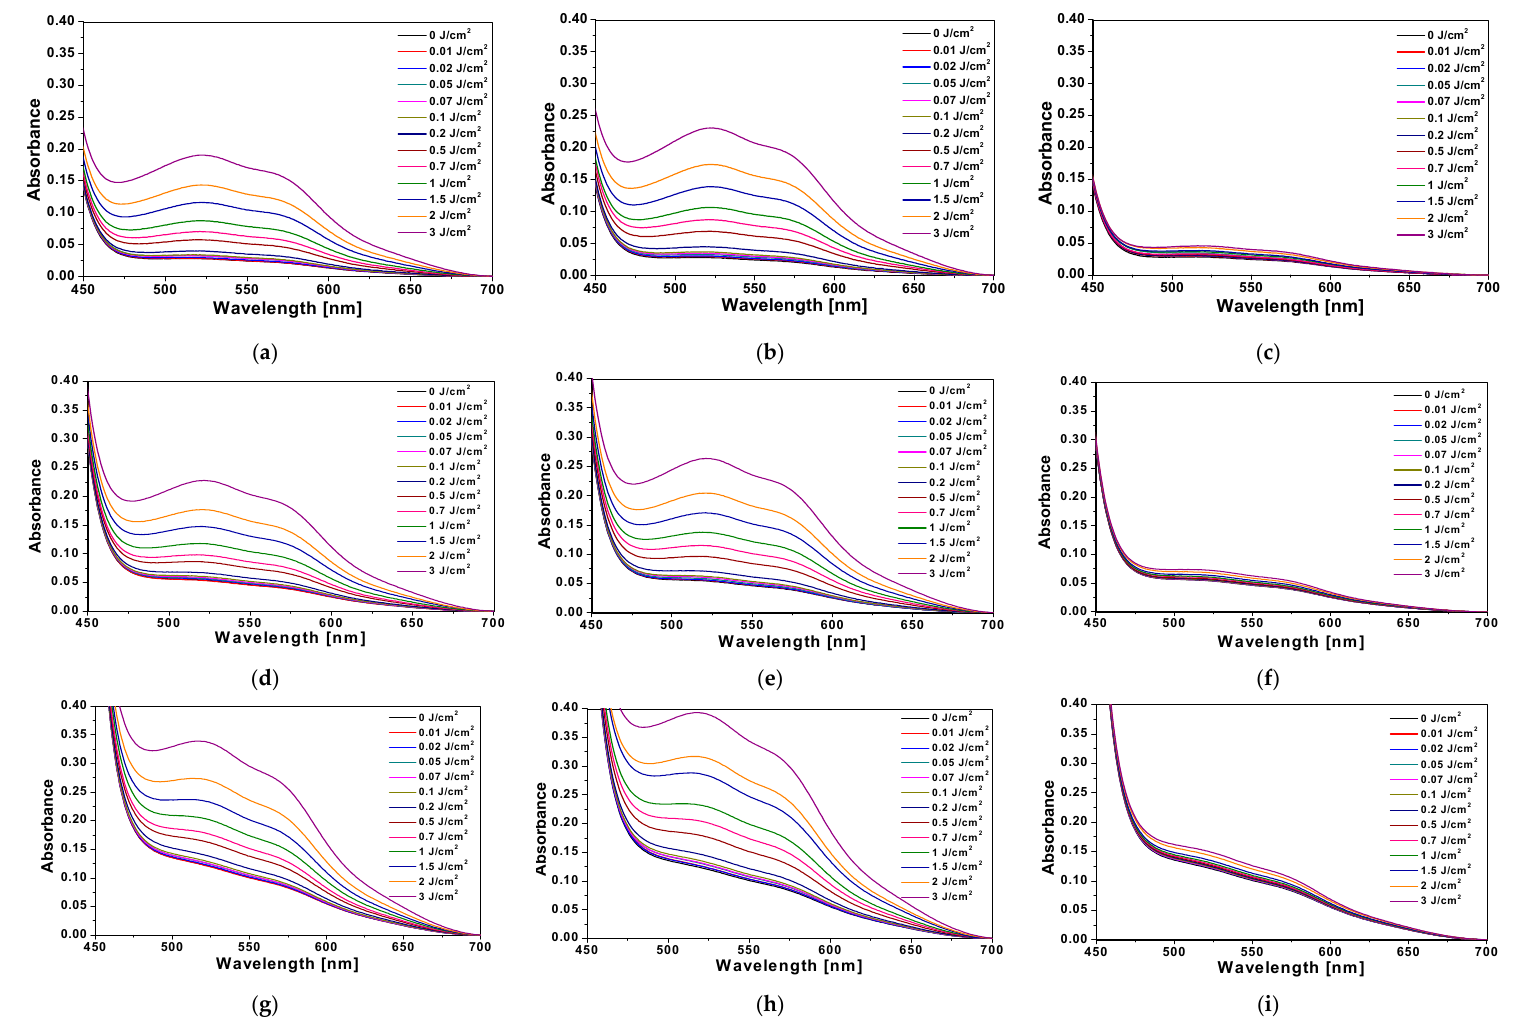
Figure 2. The absorbance spectra of NBT-Pluronic F-127 hydrogels with 1 g/dm 3 ( a – c ), 2 g/dm 3 ( d – f ) and 5 g/dm 3 ( g – i ) NBT irradiated with UVA ( a , d , g ), UVB ( b , e , h ) and UVC ( c , f , i ) radiation in the dose range of 0–3 J/cm 2 .